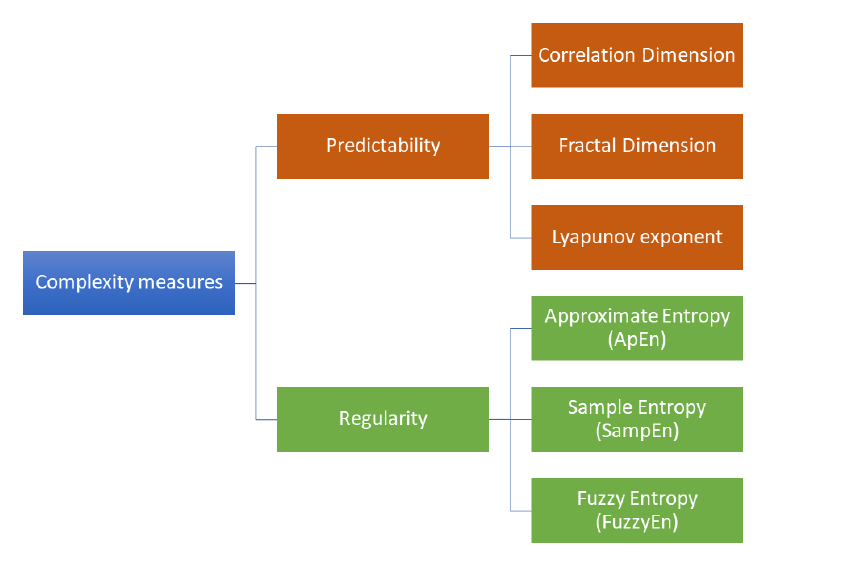
Figure 1. Classification of the most common complexity measures in neurodegenerative disease studies. Predictability measures estimate the temporal and spatial evolution of a dynamic system, whereas regularity measures take into account the presence of repeated patterns along the time